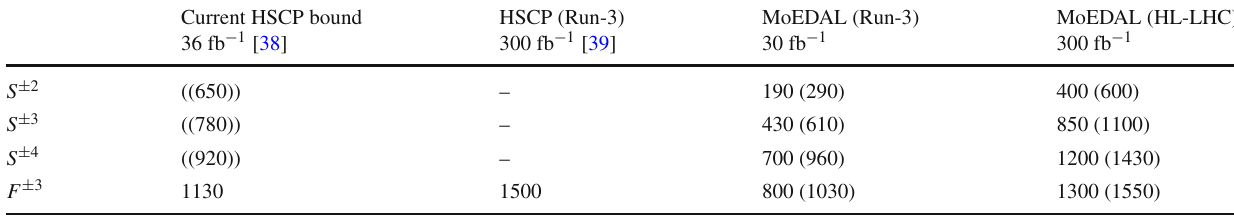
Table 2 Summary for the model-independent mass reaches (in GeV) second column represents the projected mass reach in Run-3 (300 fb − 1 ) obtained in [39]. The numbers outside (inside) the brackets in the third of the multi-charged particles in Model-1 by MoEDAL (2nd and 3rd and fourth columns represent MoEDAL’s mass reaches with N sig ≥ 3 columns). The first column shows the current mass bounds from the ATLAS analysis [38] with 36 fb − 1 . The numbers in the double-brackets (1) assuming L = 30 (Run-3) and 300 (HL-LHC) fb − 1 , respectively correspond to our naive estimate of the mass bounds (see the text). The HSCP